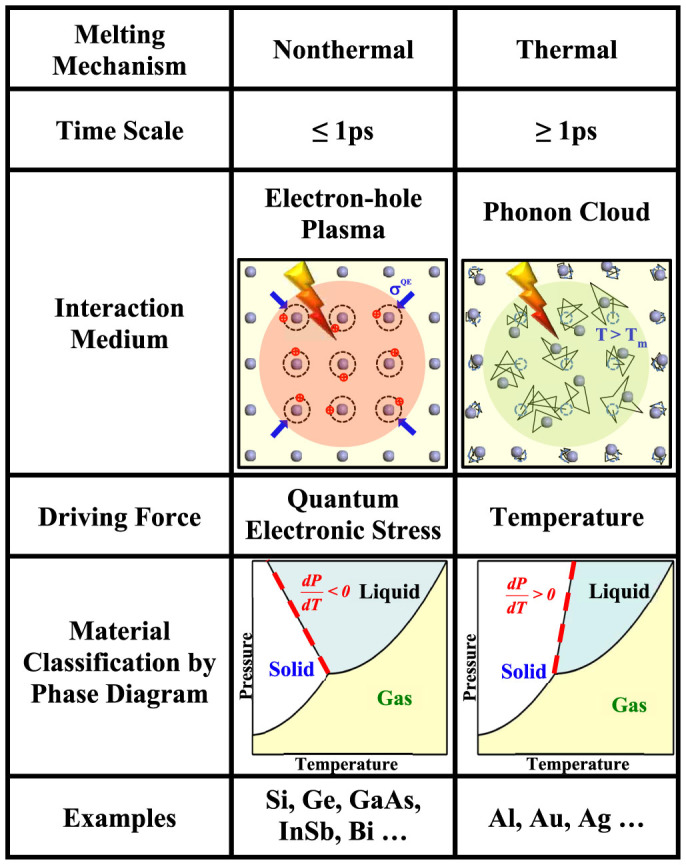
A table classifying the femtosecond pulse laser induced ultrafast crystal-to-liquid phase transitions, under high enough fluence.The distinct time scale, interaction medium, driving force, phase diagram and examples are listed to distinguish nonthermal from thermal melting process.